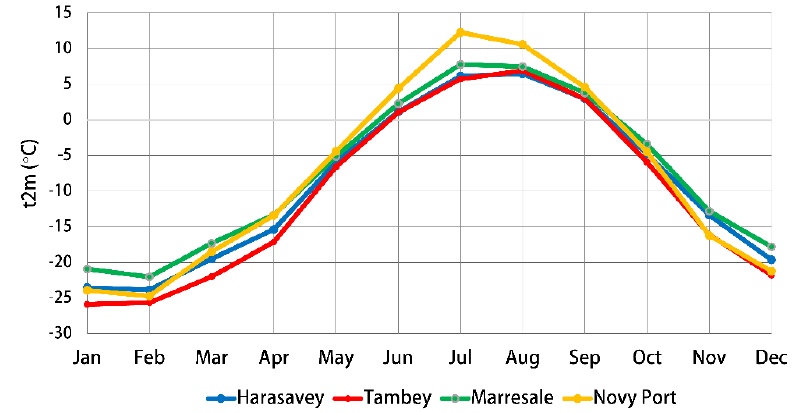
Figure 3. Averaged seasonal cycle of surface air temperature (2 m) for four meteorological stations.